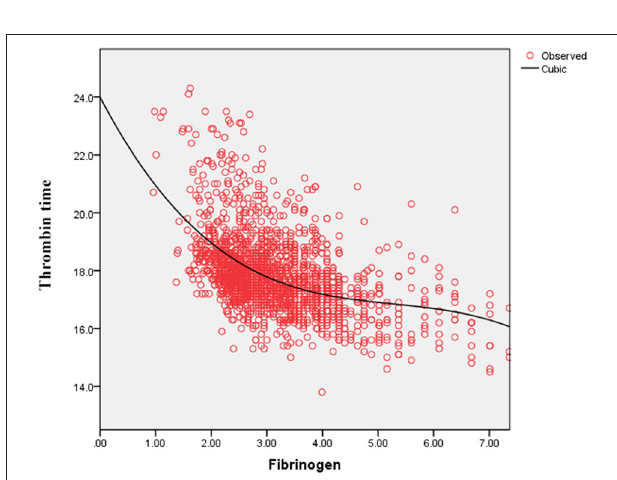
FIGURE 5 | Fitted curves of the fibrinogen level and thrombin time in patients with COVID-19.